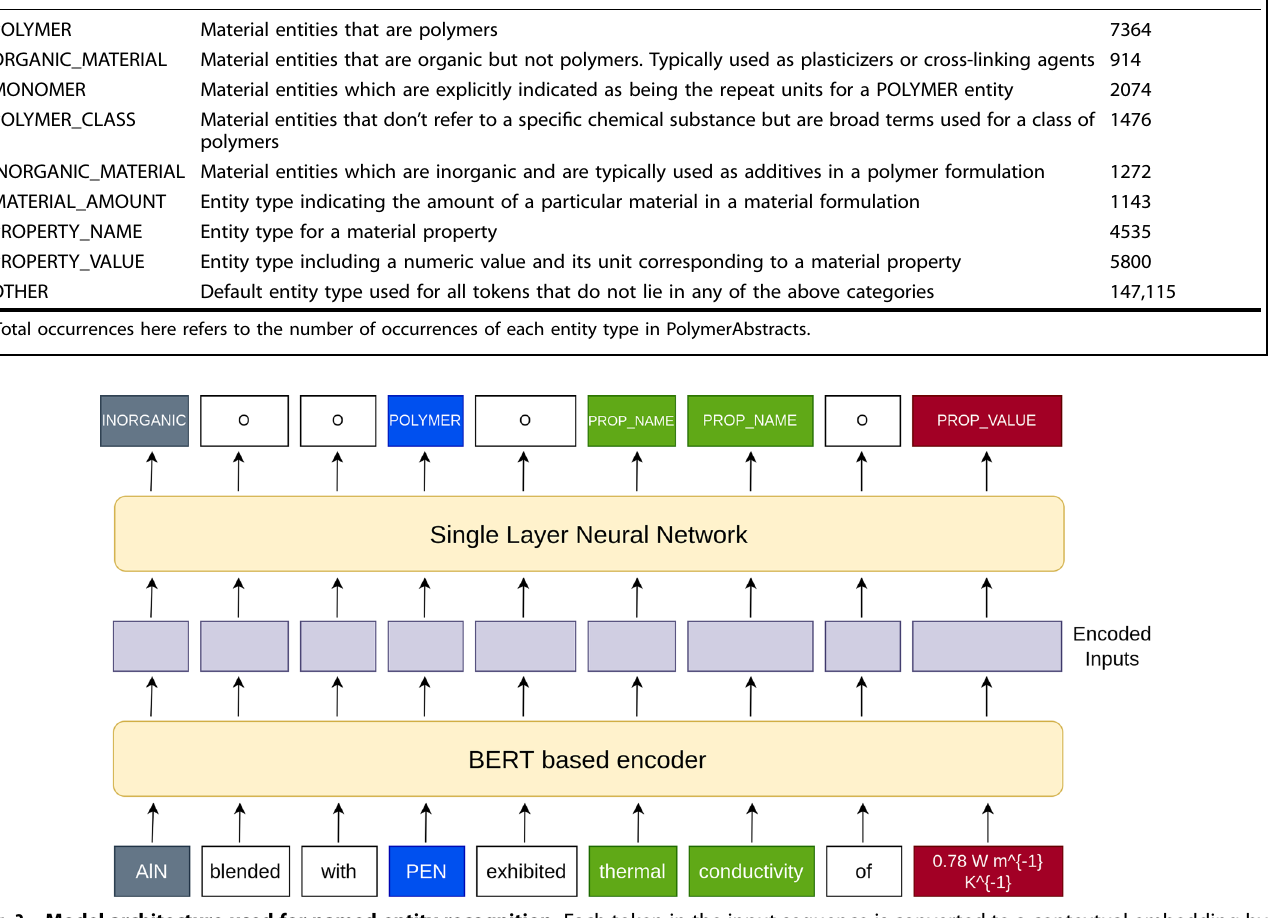
Fig. 2 Model architecture used for named entity recognition. Each token in the input sequence is converted to a contextual embedding by a BERT-based encoder which is then input to a single-layer neural network. The output of the neural network is the entity type of the input